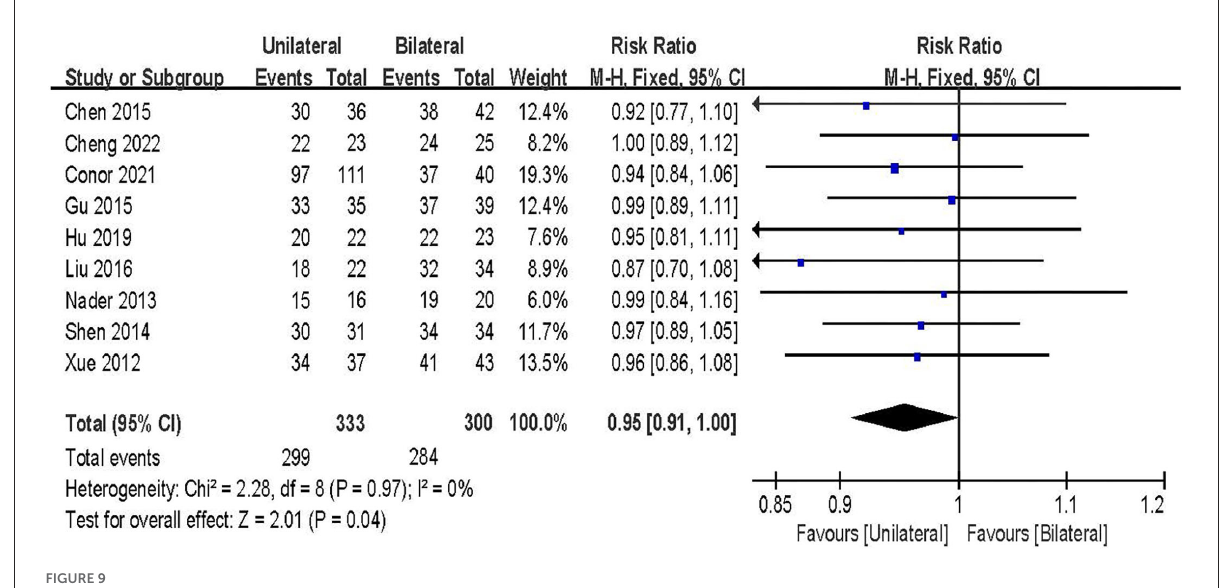
FIGURE9 Forest plot of fusion